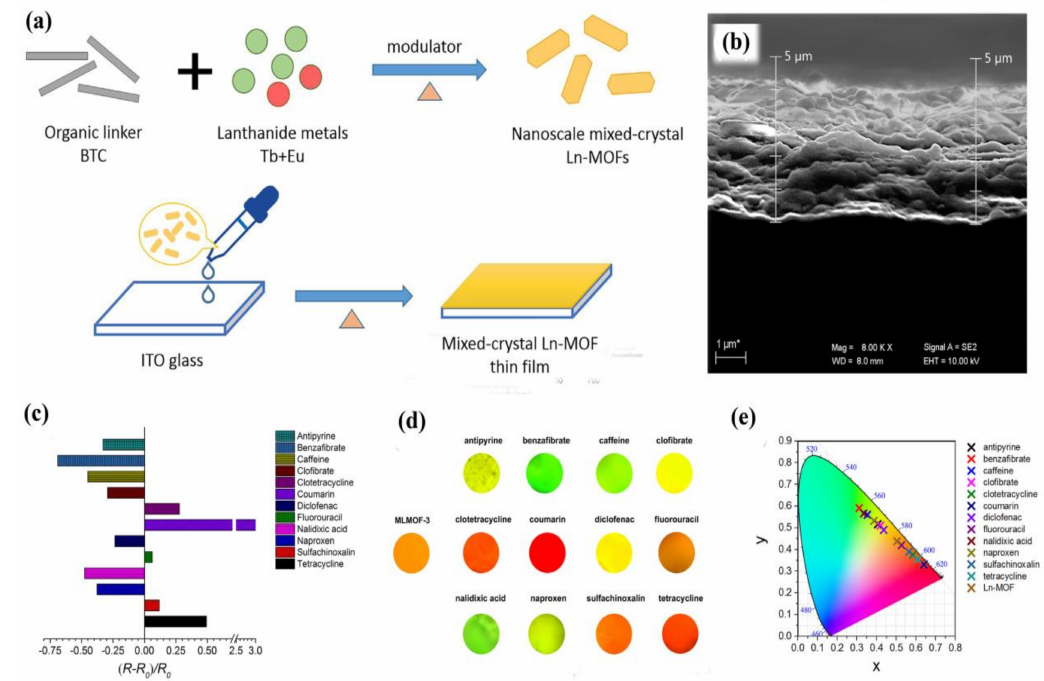
Figure 14. ( a ) Preparation process of mixed-crystal LnMOF thin film; ( b ) SEM image of cross-section of the film; ( c ) the emission intensity ratio changes; ( d ) the optical photographs; and ( e ) CIE chromaticity coordinates of the LnMOF thin film in the presence of different analytes. (20 mL, 10 − 4 M). Reproduced with permission from [127]. Copyright 2017 Elsevier